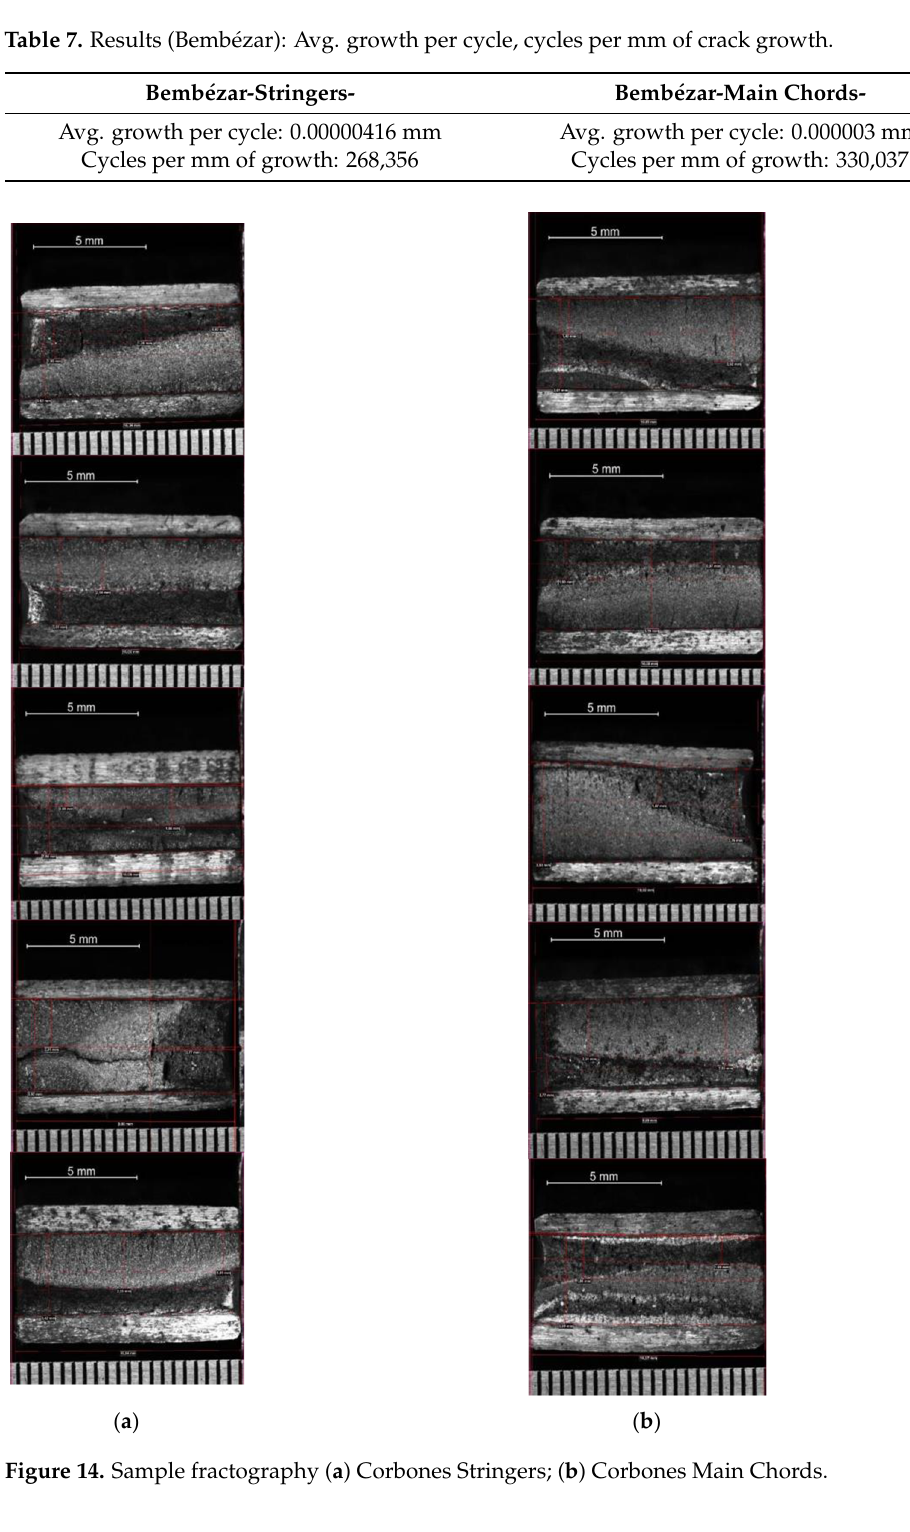
Table 4. Results Corbones: number of cycles under fatigue dynamic test (10 Hz, R:0.1)